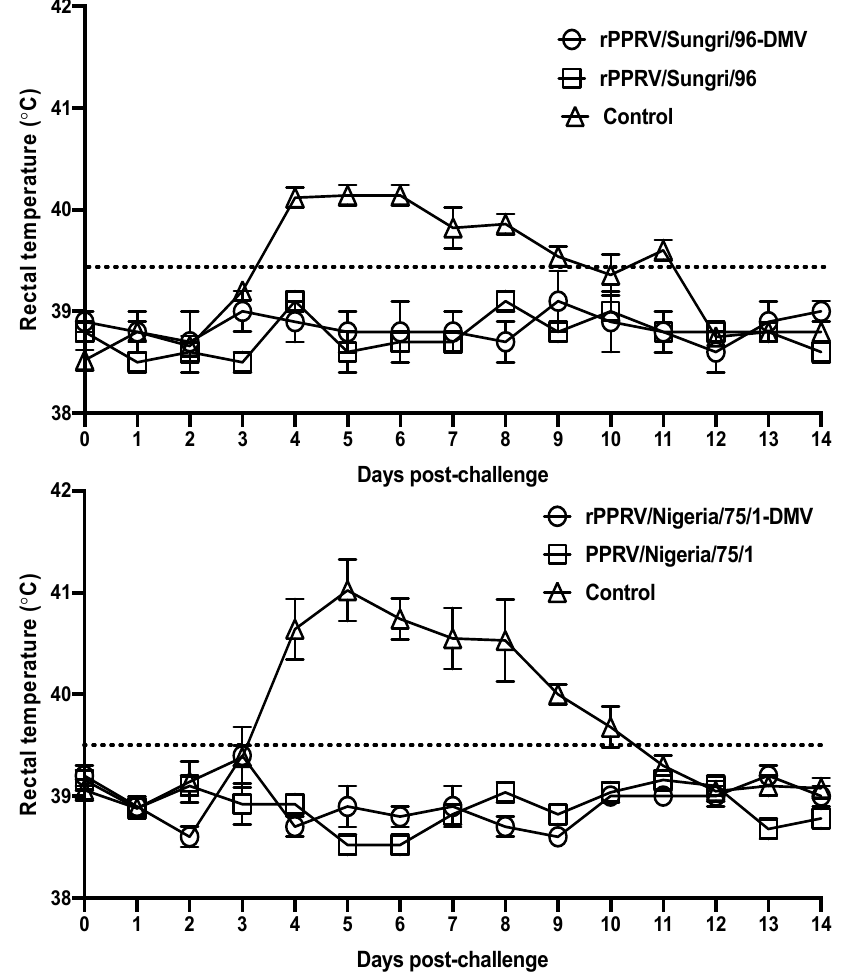
Figure 4. Rectal temperatures of vaccinated (recombinant and parent vaccine virus) and unvaccinated goats upon challenge with the virulent PPRV. The temperatures were measured twice per day and are presented as the mean values of the five animals in each group with a standard error. After 10 days post-challenge (dpc), the control group data are presented as the mean values of 2 and 4 animals in the Sungri/96 and Nigeria/75/1 experimental groups, respectively. Vaccination with the rPPRV-DIVA and conventional live attenuated vaccines did not show any immunosuppressive effects in the animals exposed to vaccine viruses and vir- ulent PPRV (Figure 5), as there was no evidence of decreased leukocyte counts. However, a severe decrease in the leukocyte count was observed in the animals in the control group from day 4 post-challenge (Figure 5).